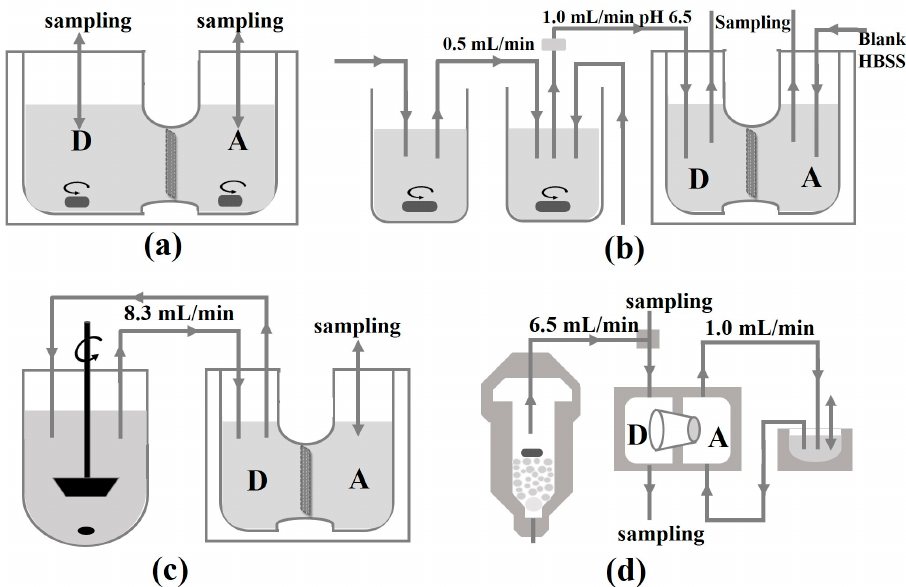
Figure 4. Schematic depiction of the published approaches for concomitant assessment of dissolu- tion and permeation. ( a ) Dissolution/permeation system (D/P system); ( b ) the drug absorption prediction system; ( c ) continuous dissolution/Caco-2 system; ( d ) flow-through/penetration system. Donor compartments are denoted as “D”, acceptor compartments as “A”. Flow rates are provided where necessary.